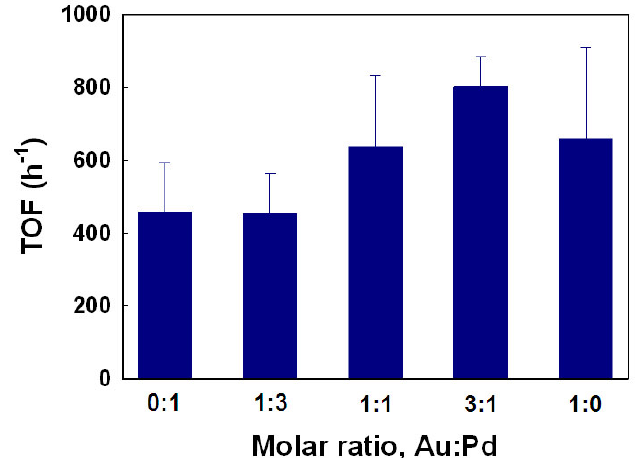
Figure 8. Turnover frequencies for the catalytic reduction of 4-NP over metal NPs @ TOCN composites, with various molar ratios of Au and